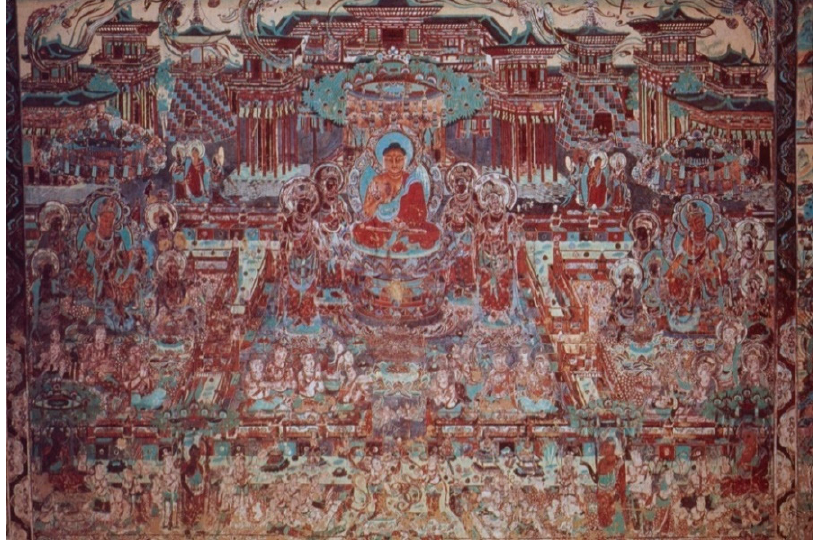
Figure 9. West Pure Land, northern wall, Dunhuang Cave 217, High Tang (Xiao 1989). The high-rise pavilions called the “louge 樓閣 ” were built on the left and right. The paired louge buildings are attached to covered galleries to connect the main hall and have different base storeys. The first is made of decorated bricks that prop up a level masonry platform with balconies, and the other is made of timber columns that support level platforms with banisters surmounted by bracket systems. The “Shigong 釋 宮 ” of